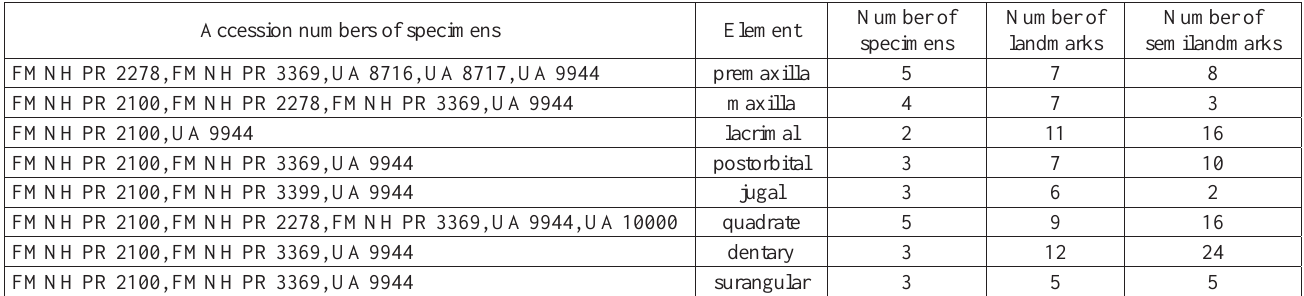
Table 1. List of isolated elements of Majungasaurus crenatissimus used in this study.